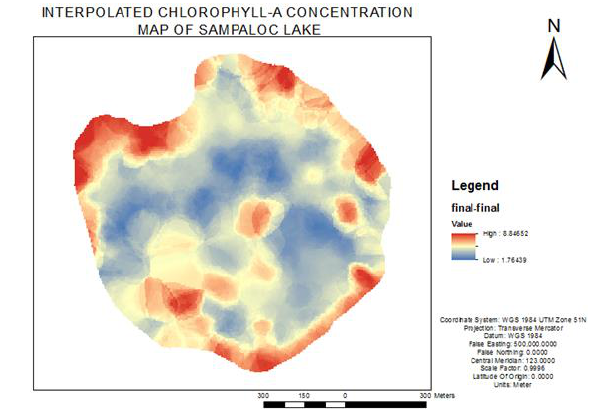
Figure 9. Interpolated chlorophyll-a concentration map